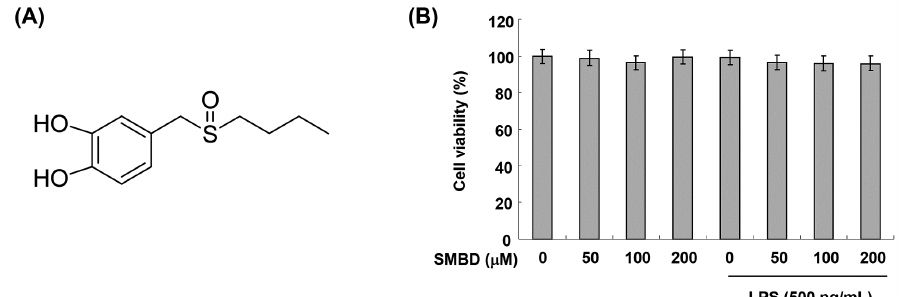
Figure 1. Effects of SMBD and LPS on the cell viability of BV2 microglia. ( A ) Chemical structure of SMBD. ( B ) Cells were treated with different concentrations of SMBD in the absence or presence of 500 ng/mL LPS. After 24 h, cell viability was assessed using an MTT reduction assay. The results are expressed as the percentage of surviving cells over control cells (without the addition of SMBD). Each value indicates the mean ± SEM of three independent